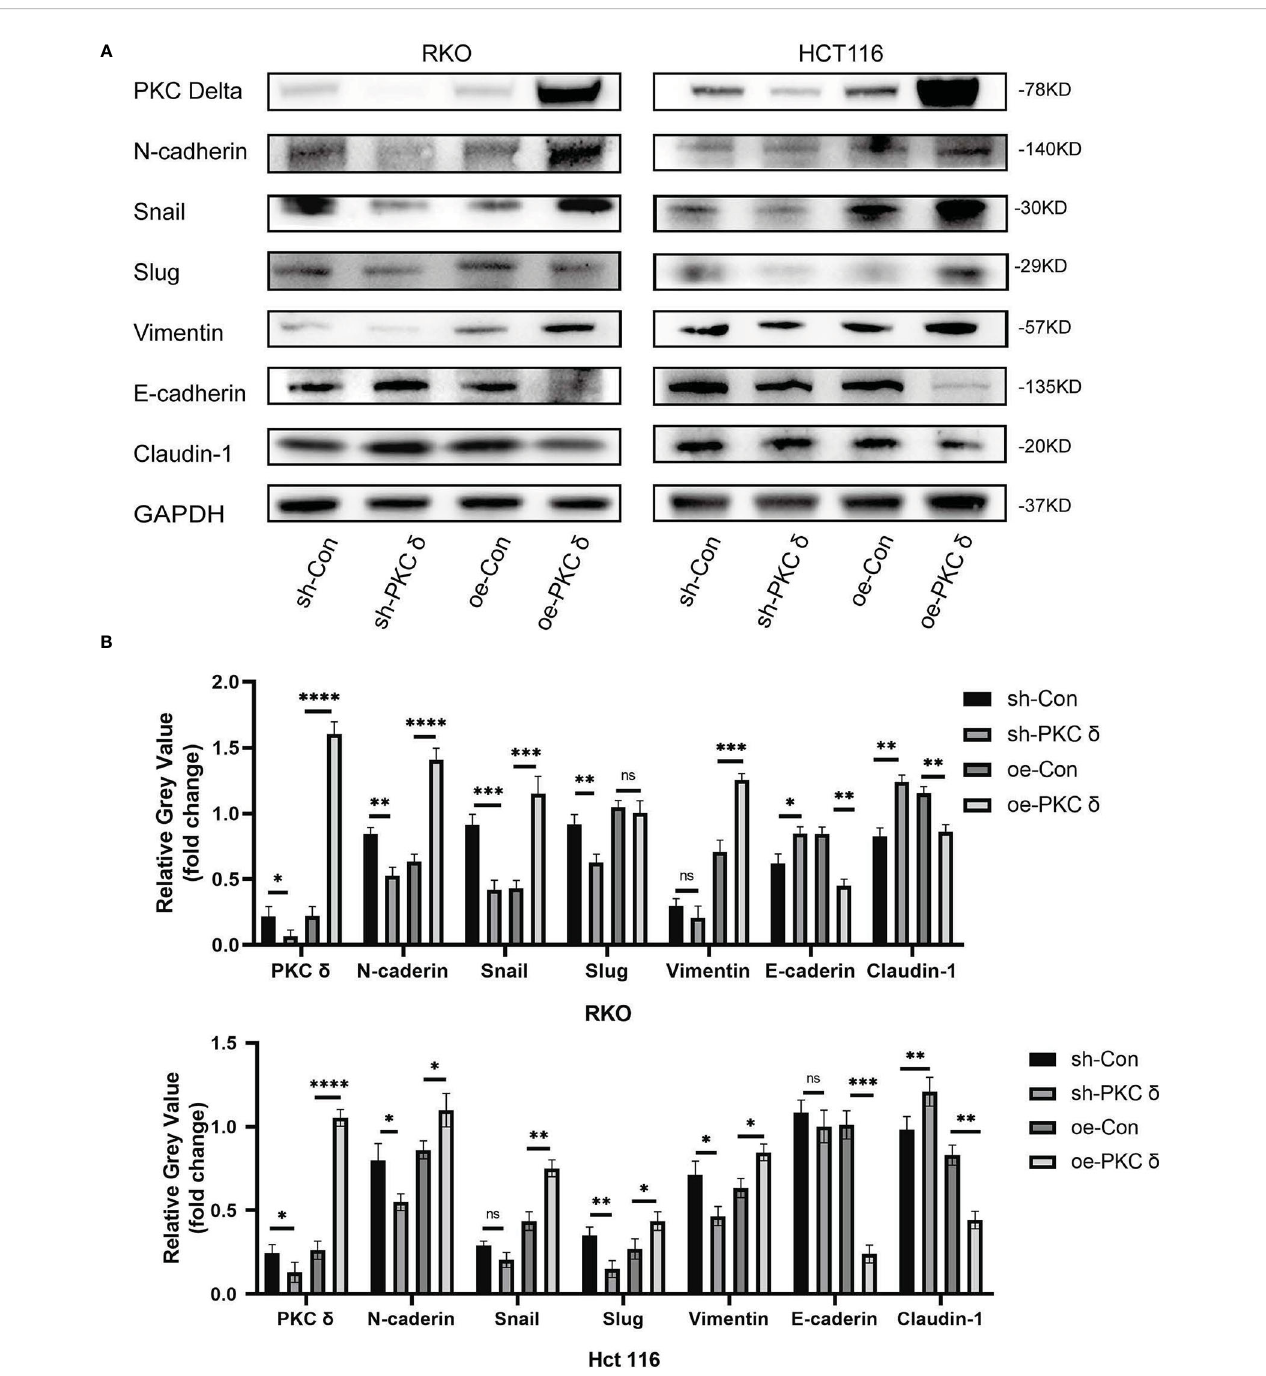
FIGURE 4 The overexpression of PKC d induces EMT of CRC cells. (A) The different changes of EMT markers when overexpression and knocking down of PKC d , detected by western blot in RKO and HCT116 cells. (B) Columns were used to quantify the protein expression in (A) relative to GAPDH. *p < 0.05, **p < 0.01, ***p < 0.001, ****p < 0.0001. ns, no signi fi